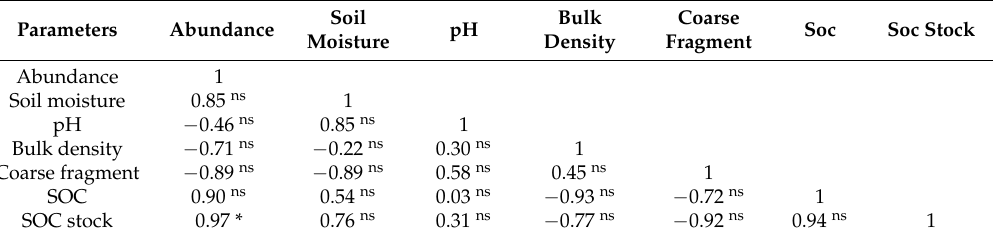
Figure 6. PCA bi plot graph of studied soil properties. Table 8. Relationship between SMI abundance and soil properties